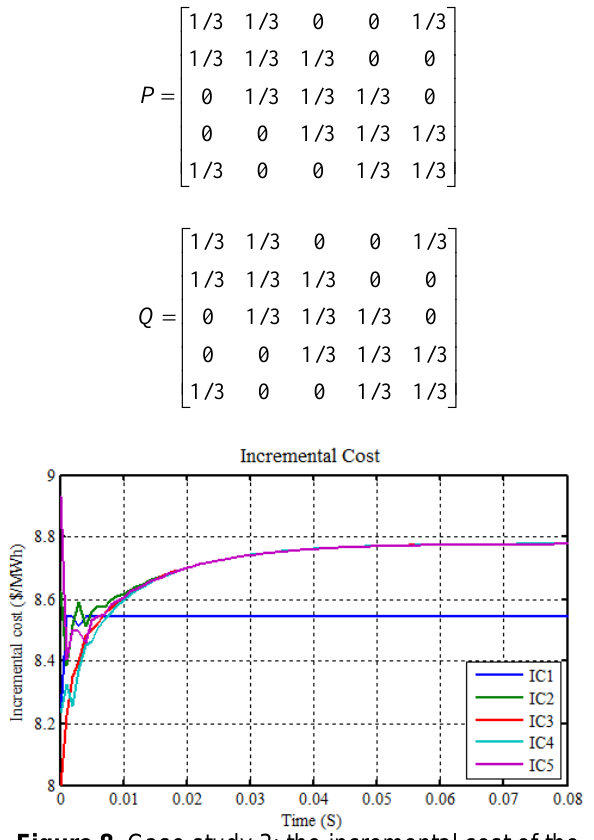
Figure 8. Case study 3: the incremental cost of the five generators.